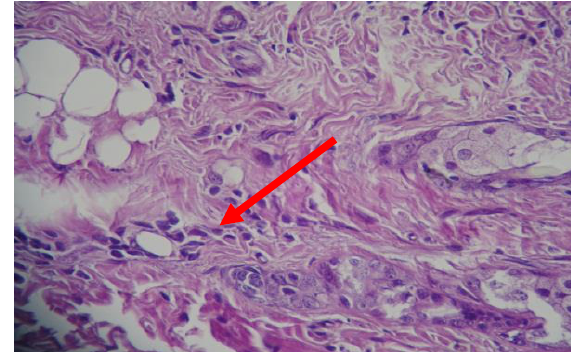
Figure,12: Section in skin of immunized animal at day 30 post challenge showed slight acanthosis with fibrotic and granulated tissue(dermal healing)with intact hair follicle (H&E Stain400X).